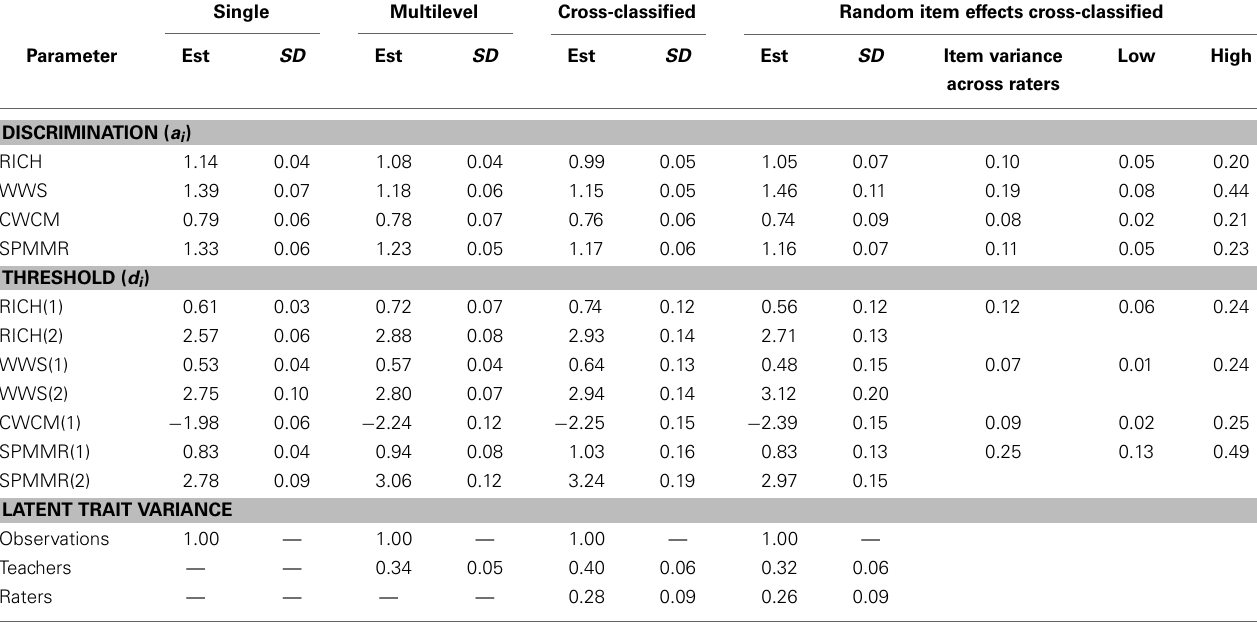
Table 1 | Discrimination and threshold parameters.